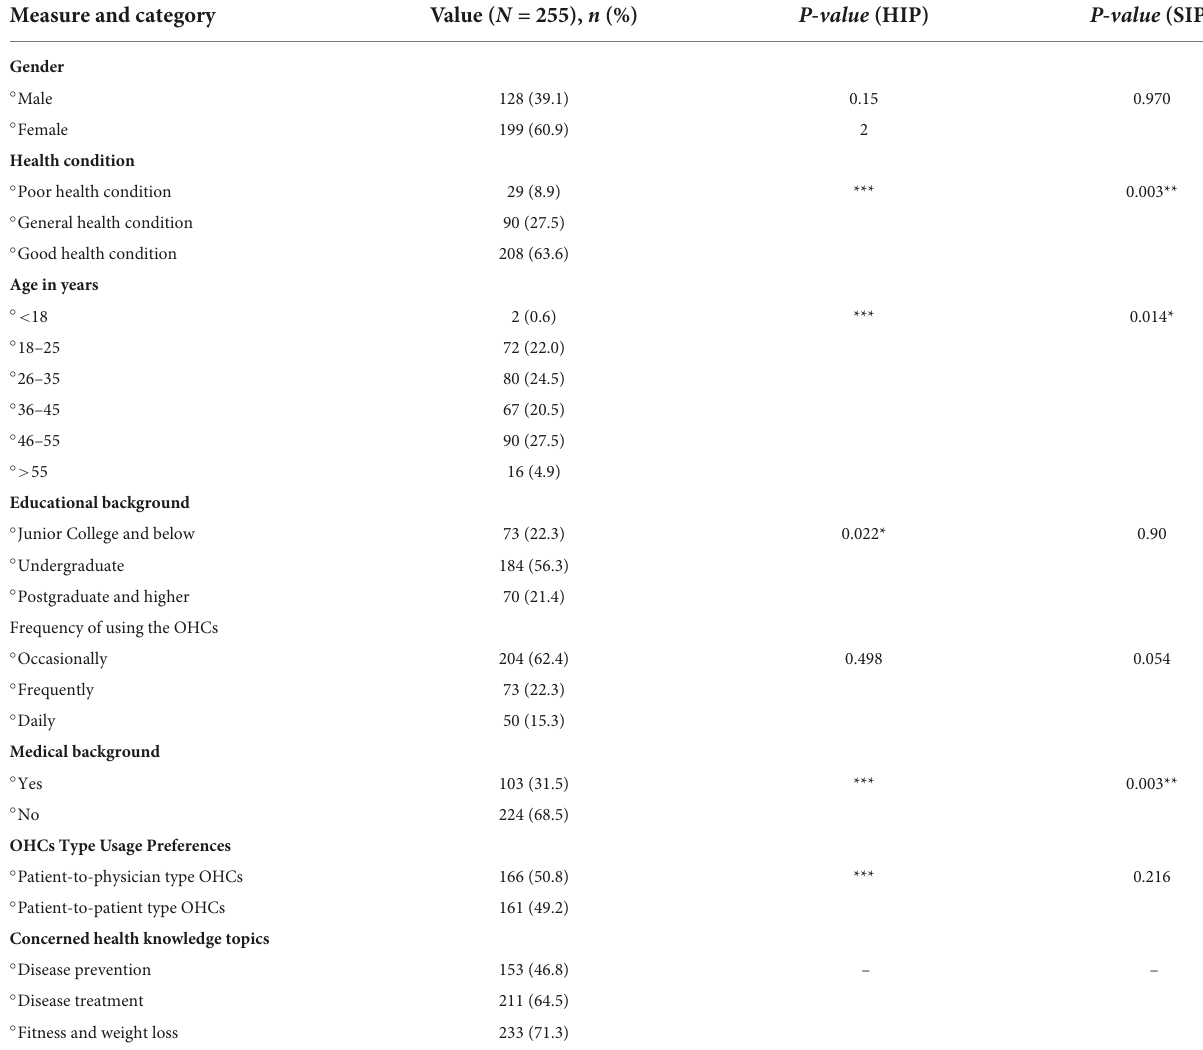
TABLE 2 Demographic characteristics of the participants ( N =